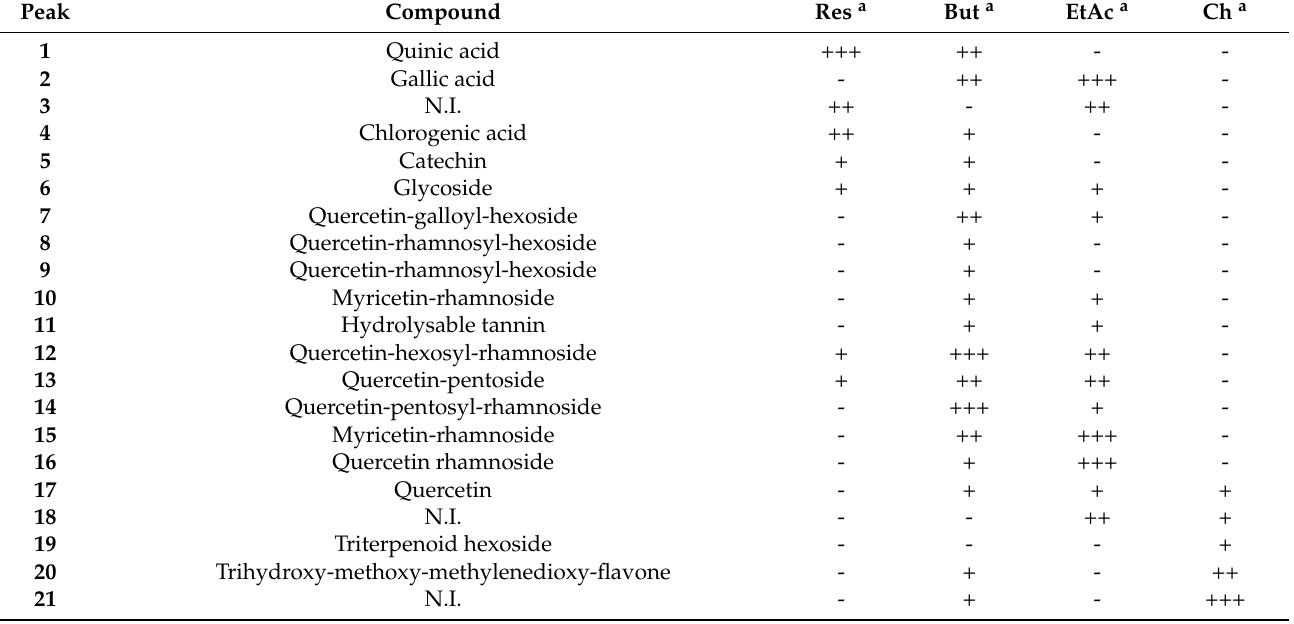
Table 3. Compounds’ distribution among the different